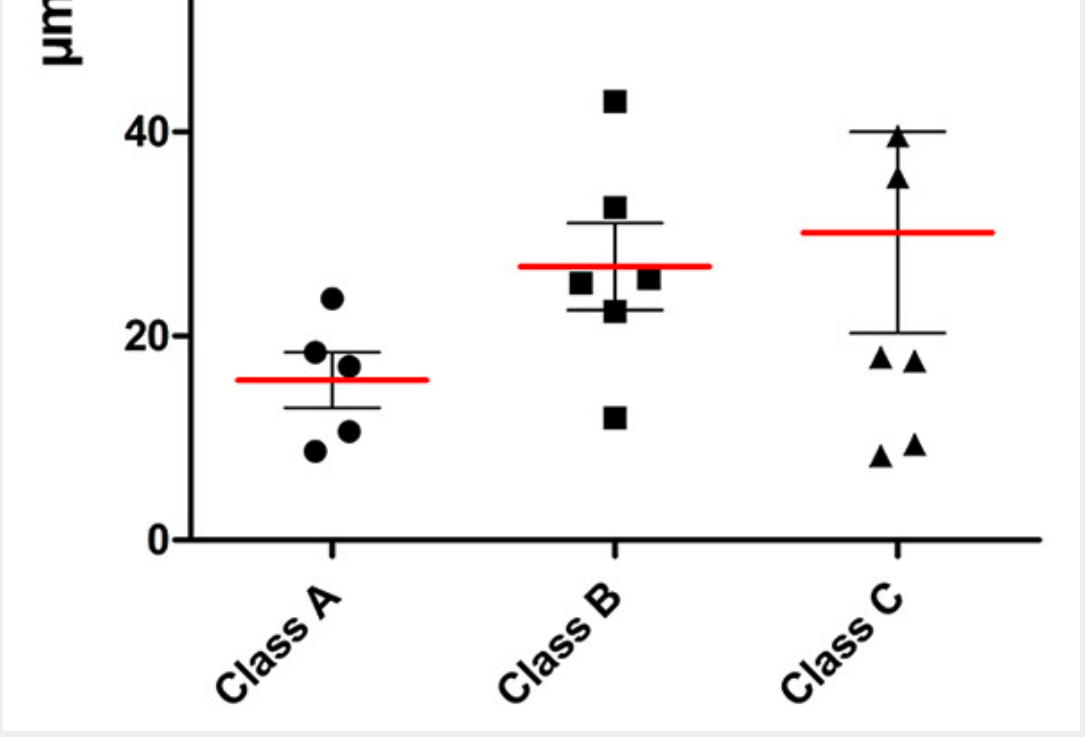
Figure 2 Volume-to-surface ratio of the collagen content of valves for the three classes ■(mean (red line), standard deviation and individual